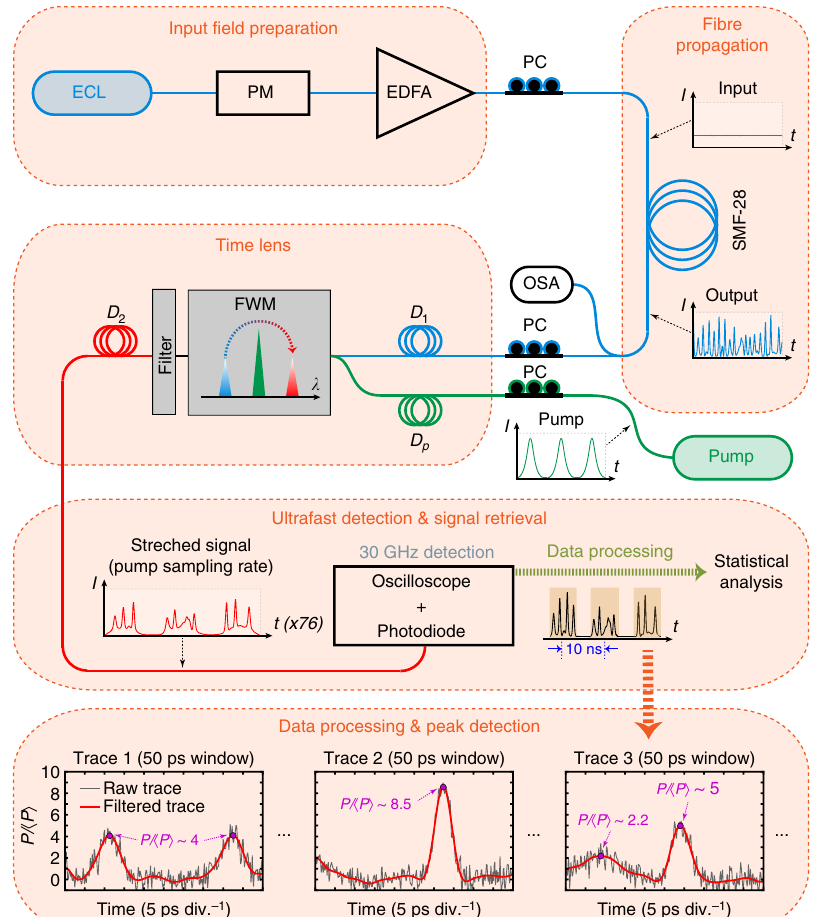
Figure 2 | Experimental setup. An external cavity laser (ECL) at 1550.3nm is phase modulated (PM) and amplified in an erbium-doped fibre amplifier (EDFA) before injection in SMF-28 single-mode fibre. The input noisy continuous wave breaks up into a random breather train which is measured using an optical spectrum analyser (OSA) and a time-lens magnifier (PicoLuz UTM-1500). The time lens uses two dispersive propagation steps ( D 1 and D 2 ), one on each side of an element that applies a quadratic temporal phase. In our experiments, the quadratic phase was applied from four wave mixing (FWM) with a linearly chirped pump pulse co-propagating in a silicon waveguide. The chirped pump pulses of duration B 90ps are generated from a femtosecond pulse fibre laser at 100MHz subsequently stretched through propagation in a fibre of dispersion D p . Optimal fidelity in the time lens requires polarization control (PC) for the pump-signal FWM in the silicon waveguide. The wavelength-converted idler after FWM (with applied quadratic phase) is filtered before further propagation in segment D 2 . The overall temporal magnification is 76.4 such that the stretched replica of the input at the output of D 2 can be resolved using a 30GHz bandwidth detection system (photodiode and ultrafast oscilloscope). The output signal takes the form of a sequence of noisy breather peaks separated by 10ns. Note that the figure plots results over a timespan of 50ps, but peak detection used only a 25ps region of the measurement window. We also show three representative signals obtained from experiment (at 17.3km propagation) plotting both unfiltered raw data (black traces), and data after filtering (see ‘Methods’ section) to remove instrumental noise (red